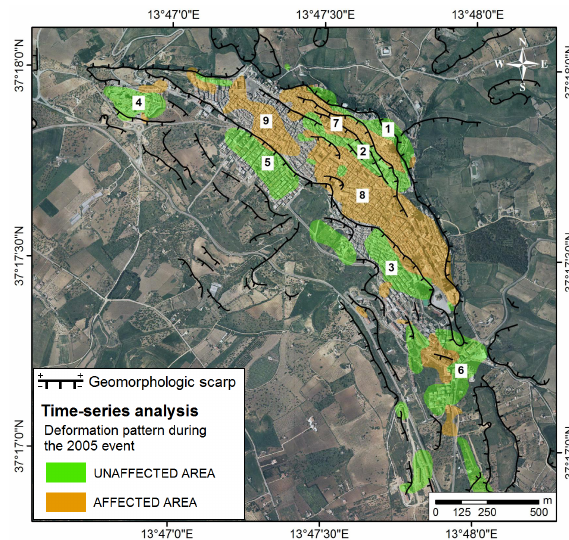
Fig. 12. Final result of the PS time series analysis and classification for Naro: identification and mapping of areas registering a homogeneous deformation pattern during the event that occurred on 4 February 2005: areas 1–6, unaffected by the event, and areas 7–9, affected. Geomorphologic scarps are overlapped on the deformation pattern